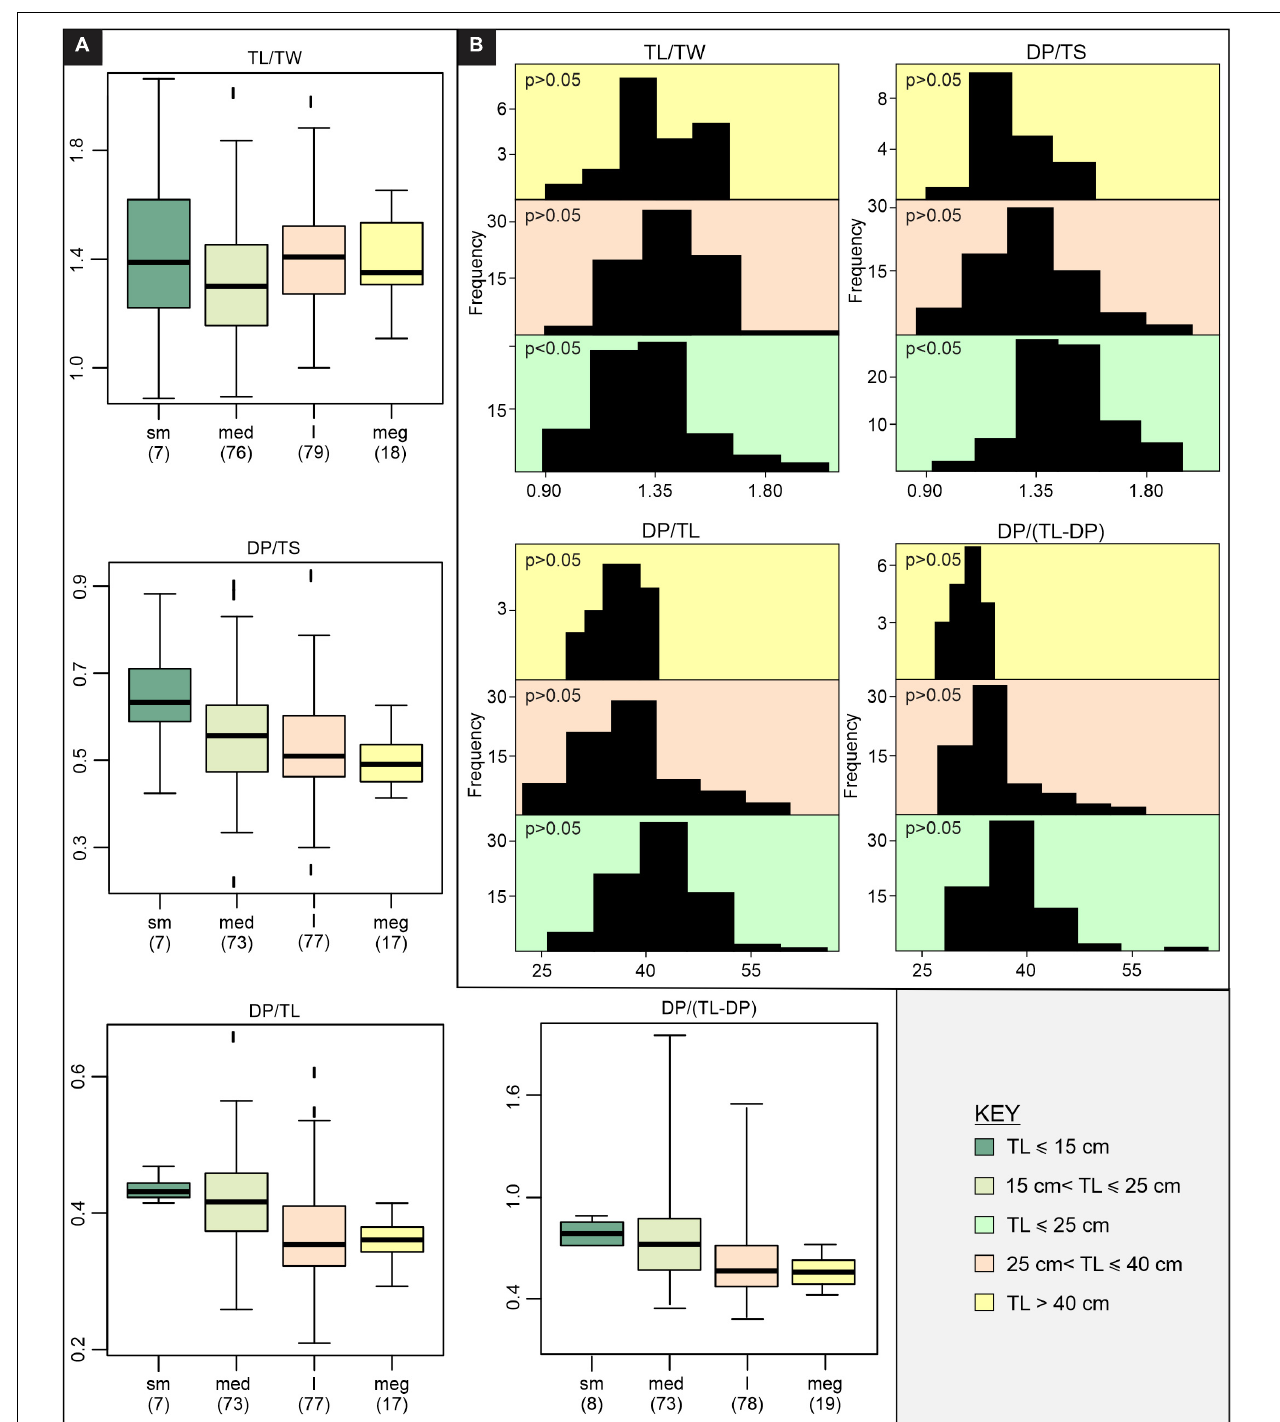
FIGURE 4 | Morphology, expressed by track bivariate ratio data, across the K-GAE plexus. (A) Boxplots showing the spread in data for considered ratios (50% of data within the box, median denoted with a black bar), (B) Frequency distributions with Shapiro-Wilk normality probabilities ( p > 0.05 follows a normal distribution) included. Due to the limited sample size of “small” tracks, TL ≤ 15 cm data are merged with 15 < TL ≤ 25 cm data. sm – small, med – medium, l – large, meg – mega, TL – track length, TW – track width, DP – digit III projection, TS – track span.